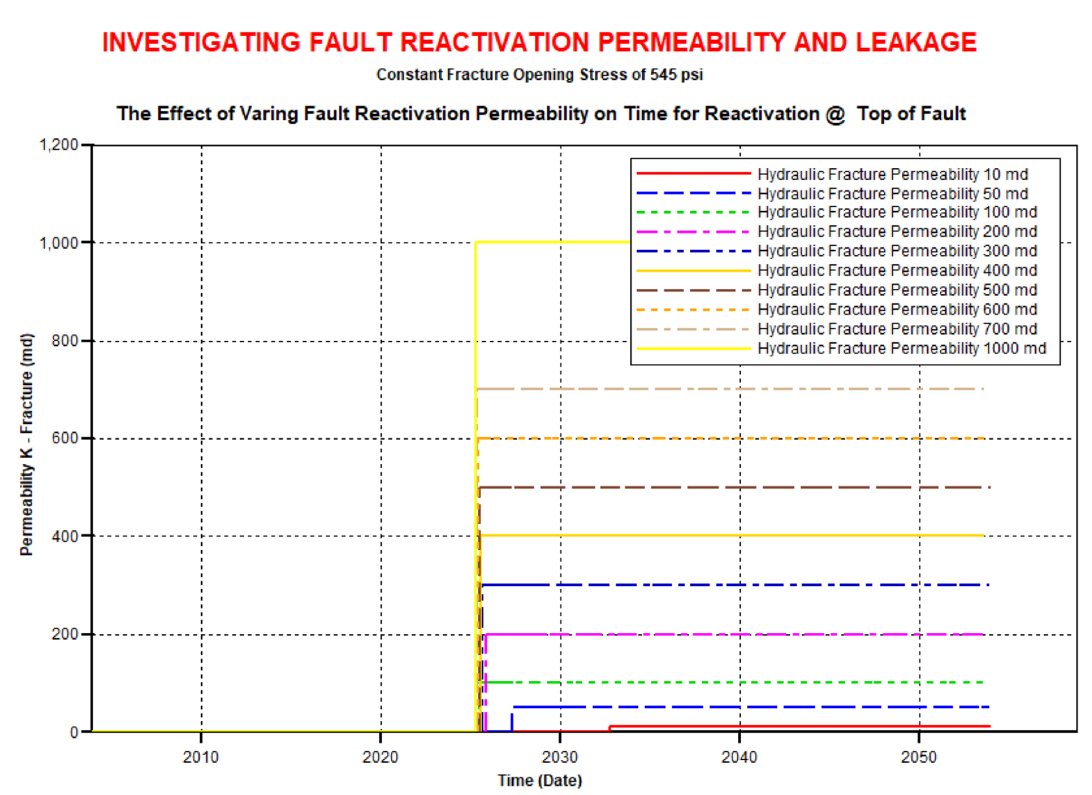
Fig. 19 The effect of varying hydraulic fracture permeability on the time taken for reactivation at the top of the